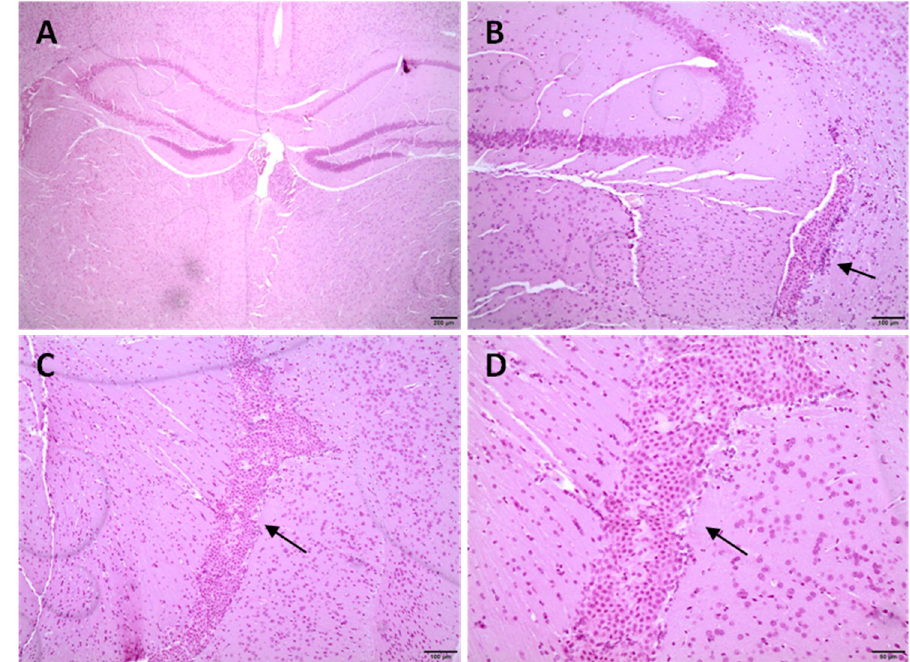
Figure 8. Histological sections of diencephalon midbrain. Cerebral samples were cut by means of a microtome and processed for hematoxylin and eosin. ( A , B ) Diencephalon sections of 24 h post-treatment (mouse 14). Minimal proliferation of the choroidal plexus epithelium (arrow). ( C , D ) Midbrain sections of 48 h post-treatment (mouse 23). Moderate proliferation of the epithelium of the choroid plexuses that occupy the lumen of one of the ventricles (arrows).